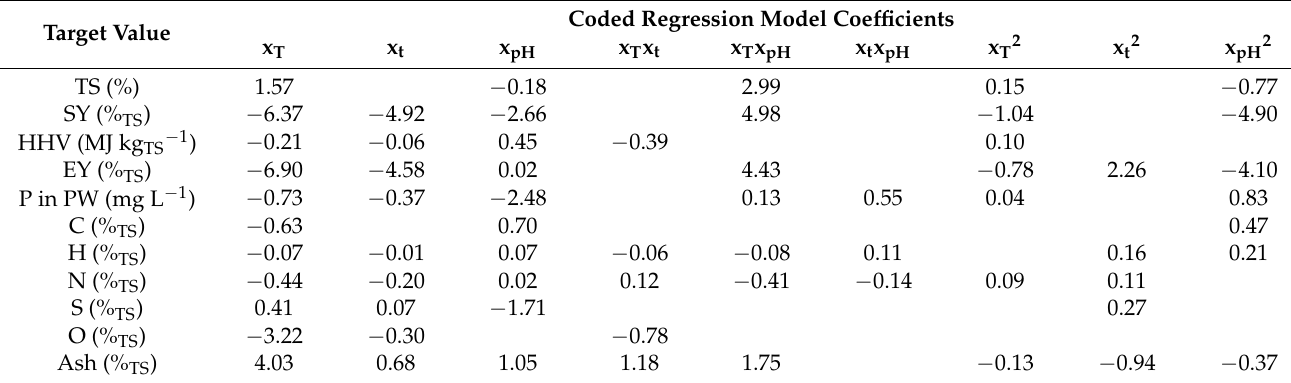
Table 4. Coded regression model coefficients for all parameters of